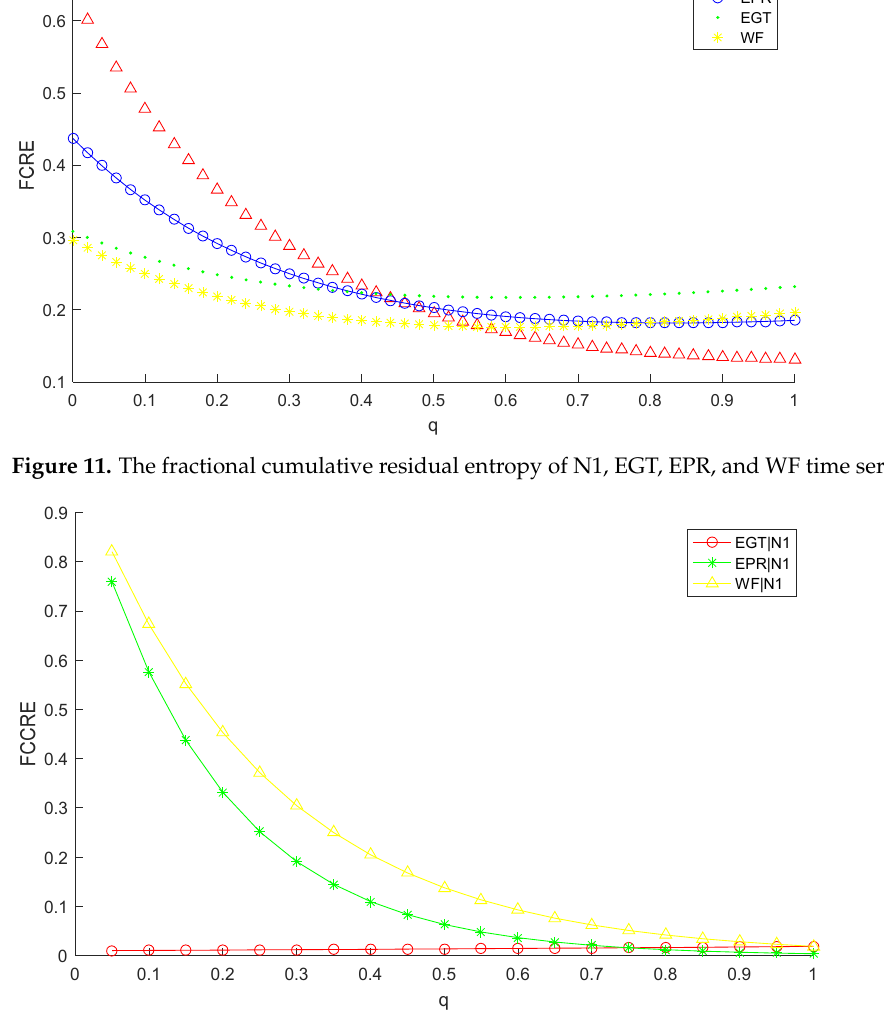
Figure 12. The fractional conditional cumulative residual entropy of aero-engine gas path time se- ries.